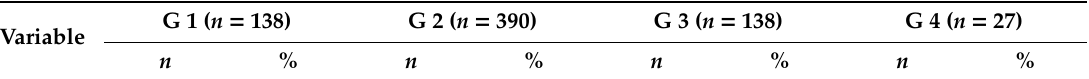
Table 6. Consumer’s buying / consumption motivations and perceptions with significant di ff erences ( p < 0.05 *) in the groups of consumers identified by cluster